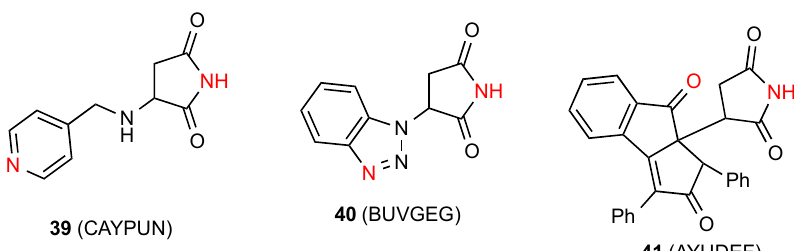
Figure 14. Monosubstituted succinimides exhibiting patterns E and F.